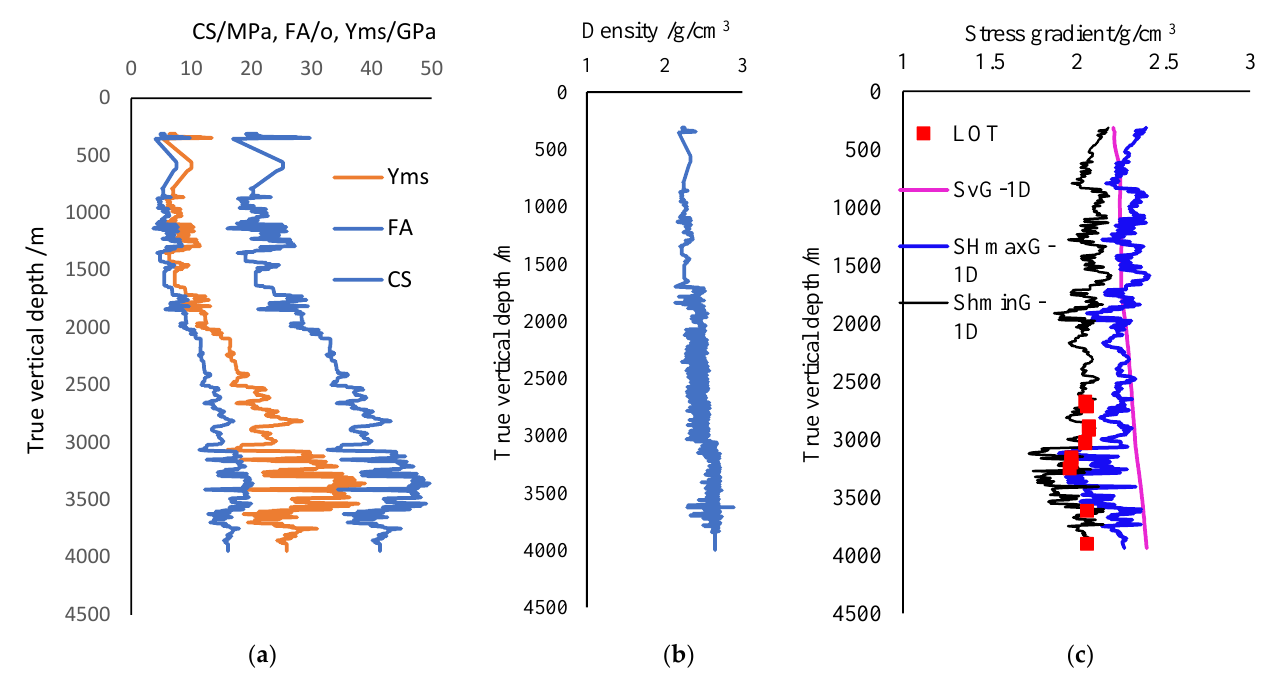
Figure 7. Results of 1D geomechanical analysis of Tugu-1 well in TS block: ( a ) Distribution of CS, FA, and E along well depth; ( b ) density of rock; ( c ) SHmin, SHmax, and Sv. Table 2. Values of k0 for the FEM